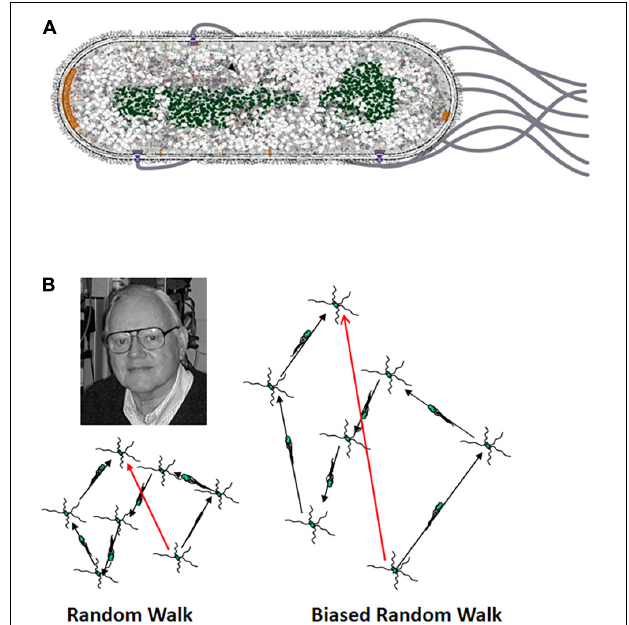
FIGURE 1 | (A) Diagram of an E. coli cell. E. coli is a rod-shaped, gram-negative bacterium. It has an inner and outer membrane with a thin but relatively rigid peptidoglycan (PG) cell wall in the periplasmic space between the two membranes. The four to six flagella arise at random points along lateral surface of the cell cylinder. The proximal hook serves as a universal joint to allow rotation of the flagellum perpendicular to the cell envelope to bend 90 ◦ so that the left-handed helical flagellar filaments can come together to form a bundle that pushes the cell. The nucleoid is shown in green, and the chemoreceptor patches at the cell poles are shown in orange. The patch at the old pole is larger. In this image it is at the leading end of the cell, although the old pole can be either at the leading or trailing end (Berg and Turner, 1995). (B) The three-dimensional random walk. The image at the left shows a two-dimensional projection of a cell that is running and tumbling in three dimensions. The image to the right shows a cell that is swimming in a gradient of an attractant chemical with a higher concentration at the top. The runs in the up-gradient direction are longer than in the image to the left, whereas the runs in the down-gradient direction are of the same length. The shorter runs in the absence of an attractant gradient provide space for Howard Berg to look on approvingly from the upper